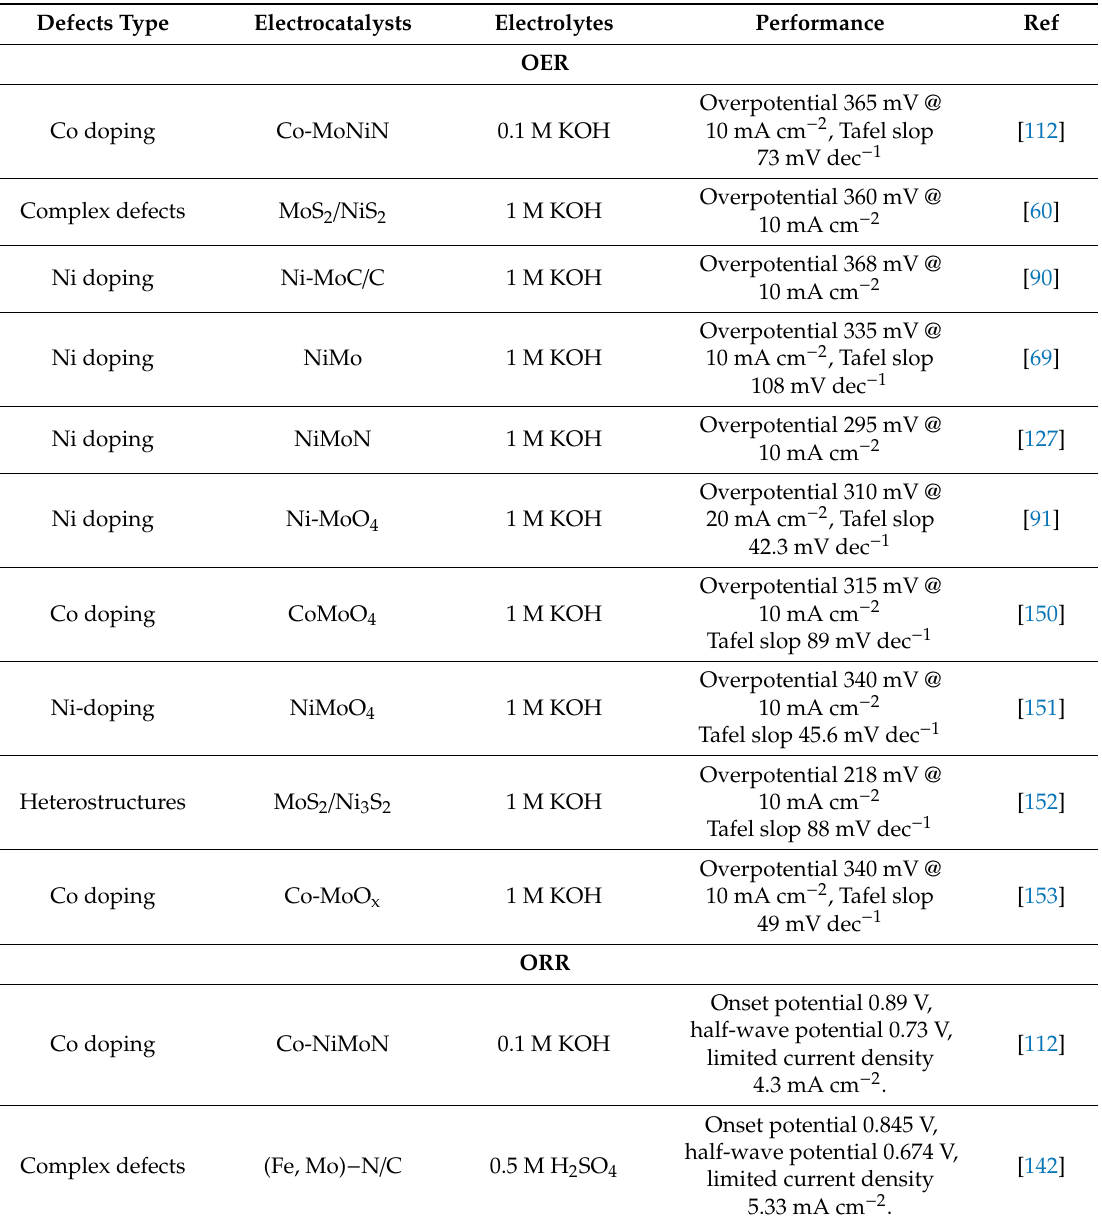
Table 2. Summary of Mo-based defect electrocatalysts for oxygen evolution reaction (OER), oxygen reduction reaction (ORR), and electrochemical nitrogen reduction